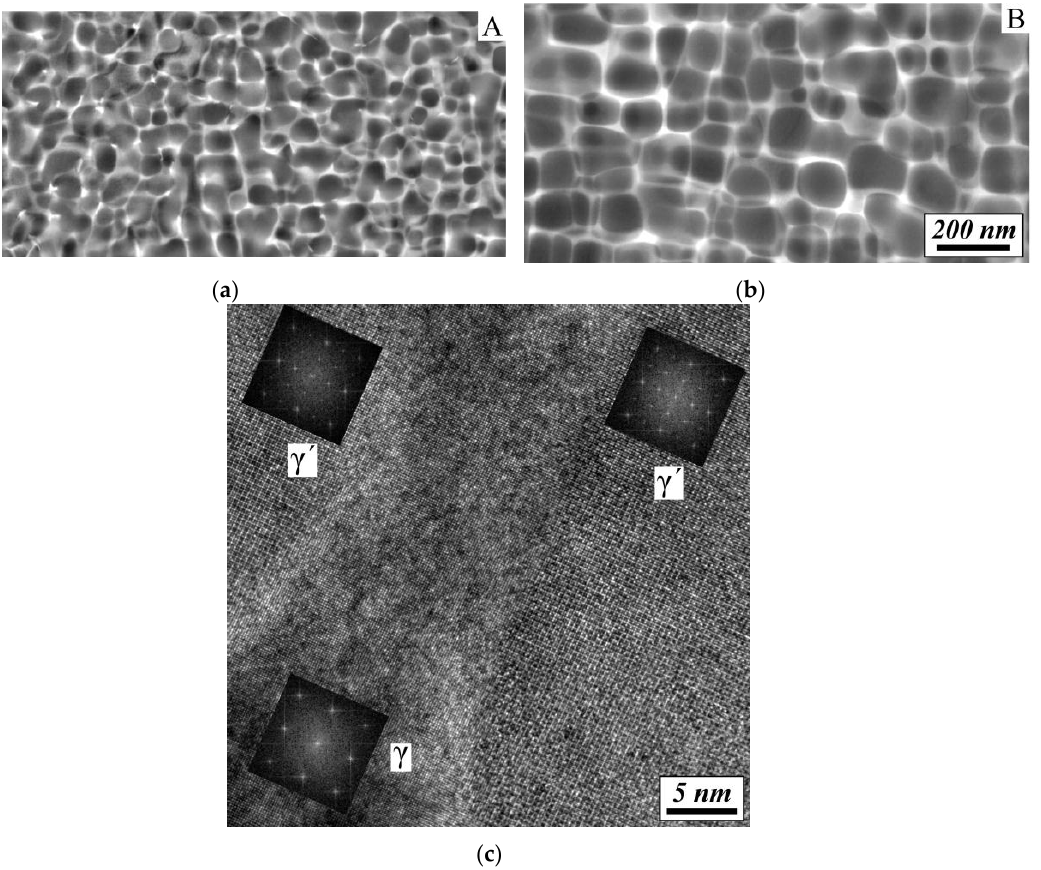
Figure 13. STEM-HAADF images documenting γ/γ′ microstructures in SEBM Specimens A and B at higher magnifications: ( a ) smaller γ′ particles in Specimen A; ( b ) larger γ′ particles in Specimen B; and ( c ) HRTEM (high resolution TEM) micrograph together with calculated FFT (fast Fourier transformation) patterns showing a thin γ channel in between two coherent γ′ particles.